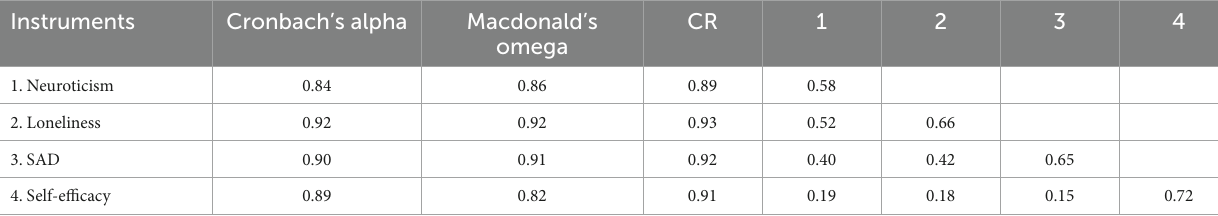
TABLE 2 Reliability, average variance extracted, and discriminant validity. Instruments